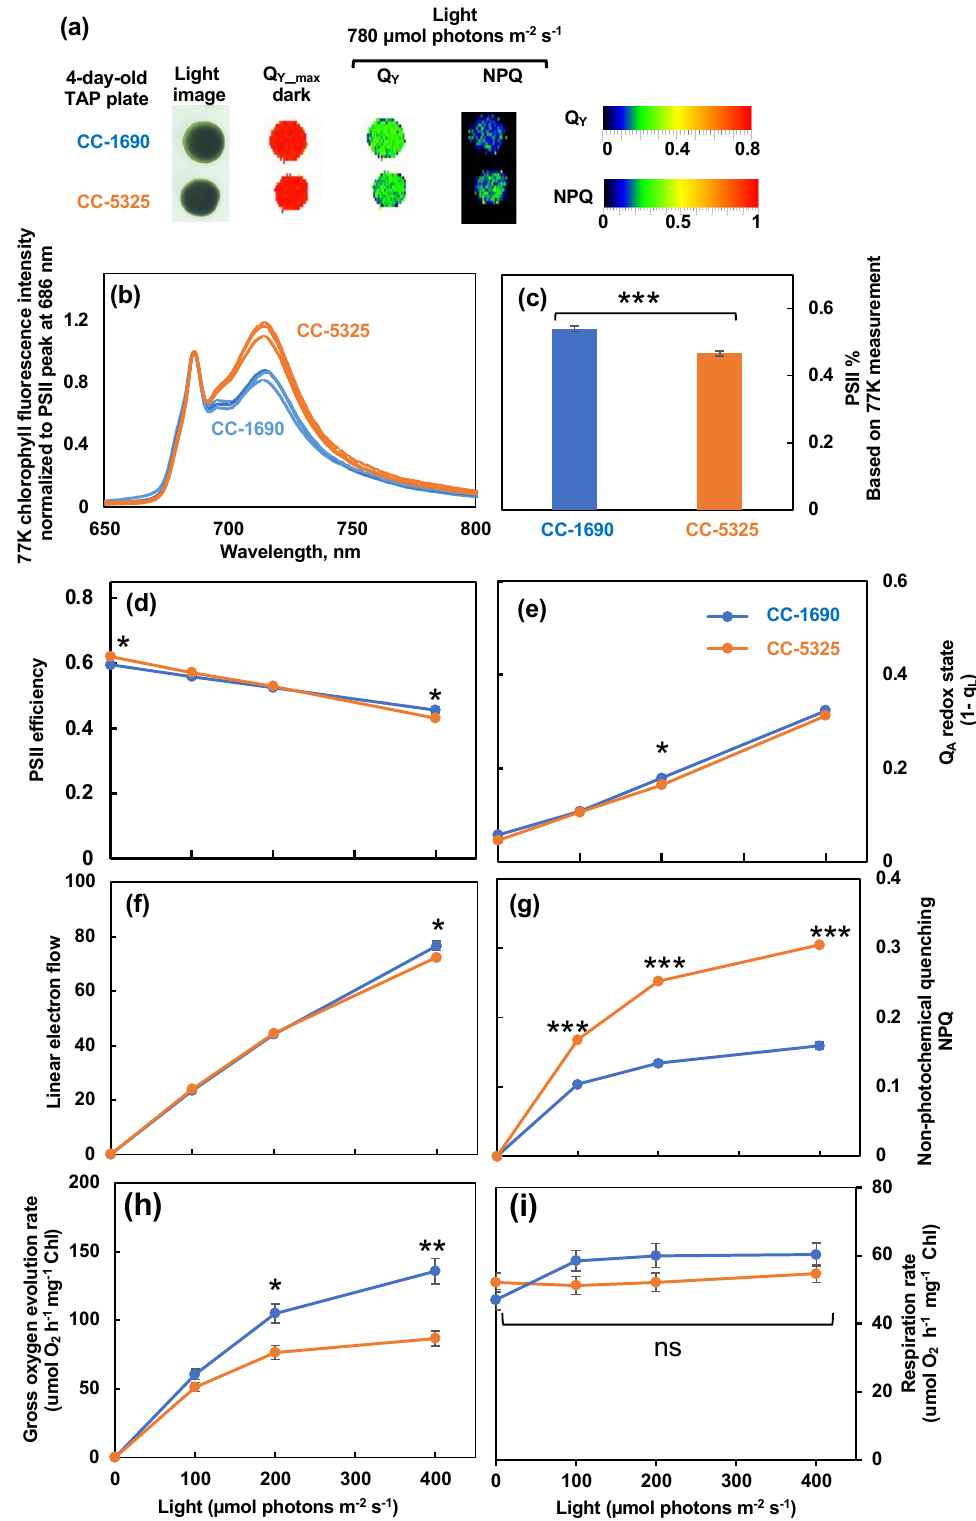
Figure 4. CC-1690 had higher photosynthetic efficiency than CC-5325. ( a ) Chlorophyll fluorescence imaging of 4-day-old algal spots grown on TAP plates at 25 °C under 150 μ mol photons m − 2 s − 1 white LED lights in incubators. Chlorophyll fluorescence imaging was performed by using FluorCam (Photo System Instruments). Q Y-max , maximum PSII efficiency in dark-adapted plates. Under 780 μ mol photons m − 2 s − 1 light, Q Y and NPQ are PSII operating efficiency and non-photochemical quenching in light-adapted plates, respectively. Color bars represent values of Q Y and NPQ. ( b – i )